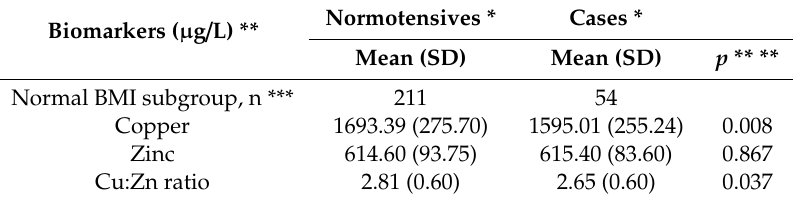
Table 2. Serum copper and zinc concentrations (in 10–14 gestational week) in the normal body mass index (BMI) subgroup.